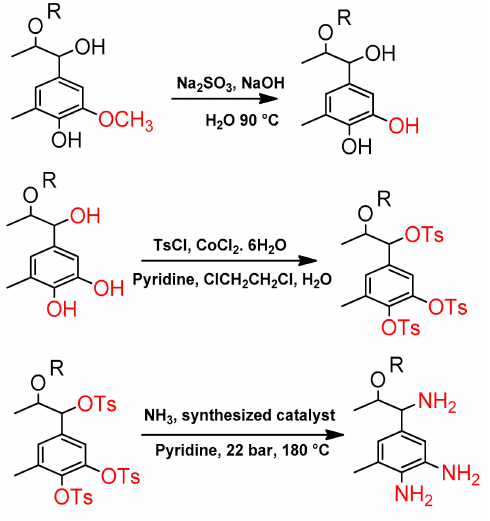
Figure 2. All steps in the synthesis of a lignin-based curing